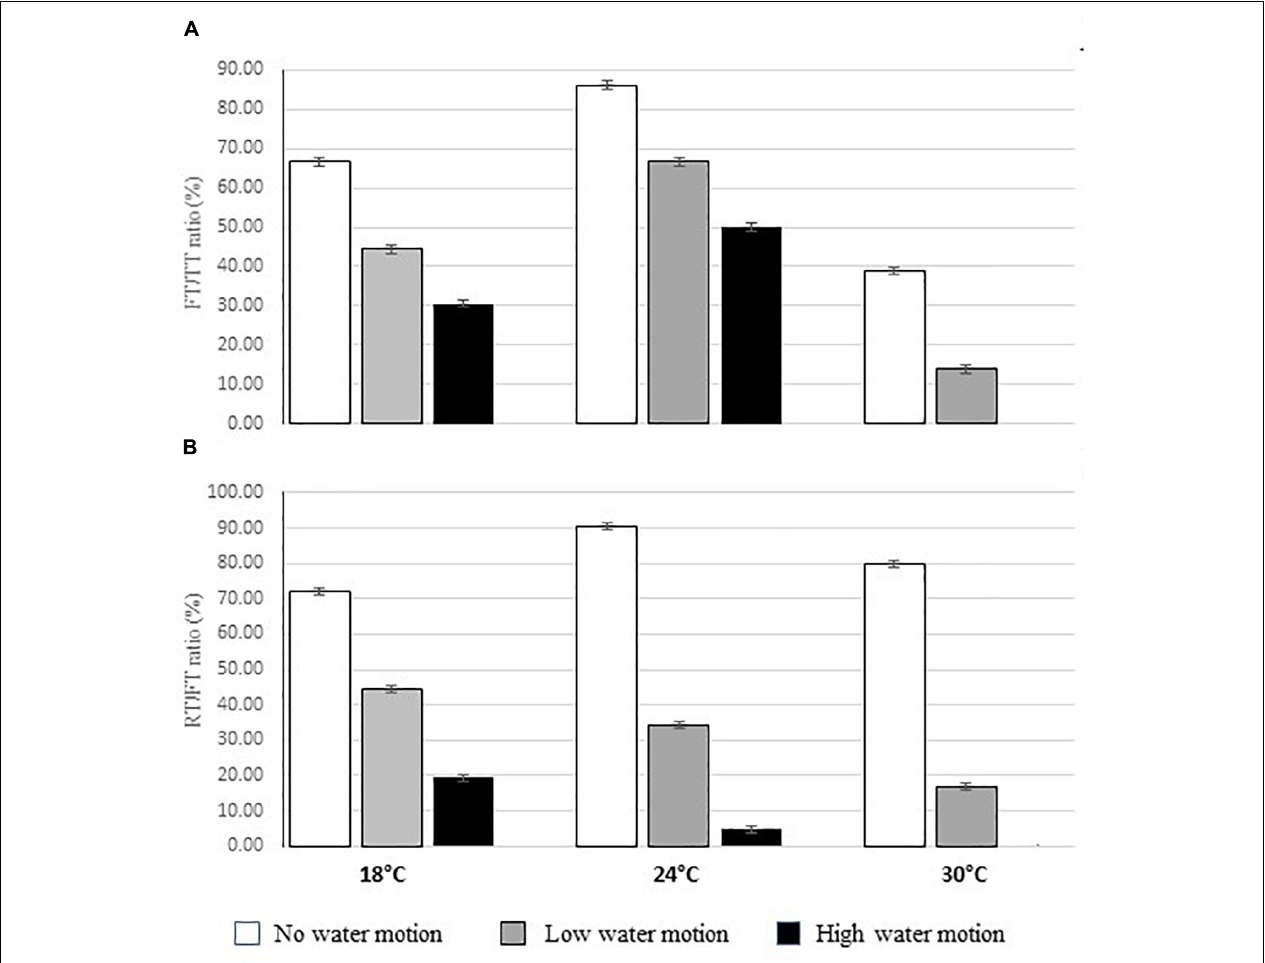
FIGURE 7 | Mean ( ± ES) ratio between the number of FT and the total number of thalli (FT/TT%) (A) and between the number of releasing thalli (RT) and that of fertile ones (RT/FT %) (B) in the aquaria with different temperature and water motion